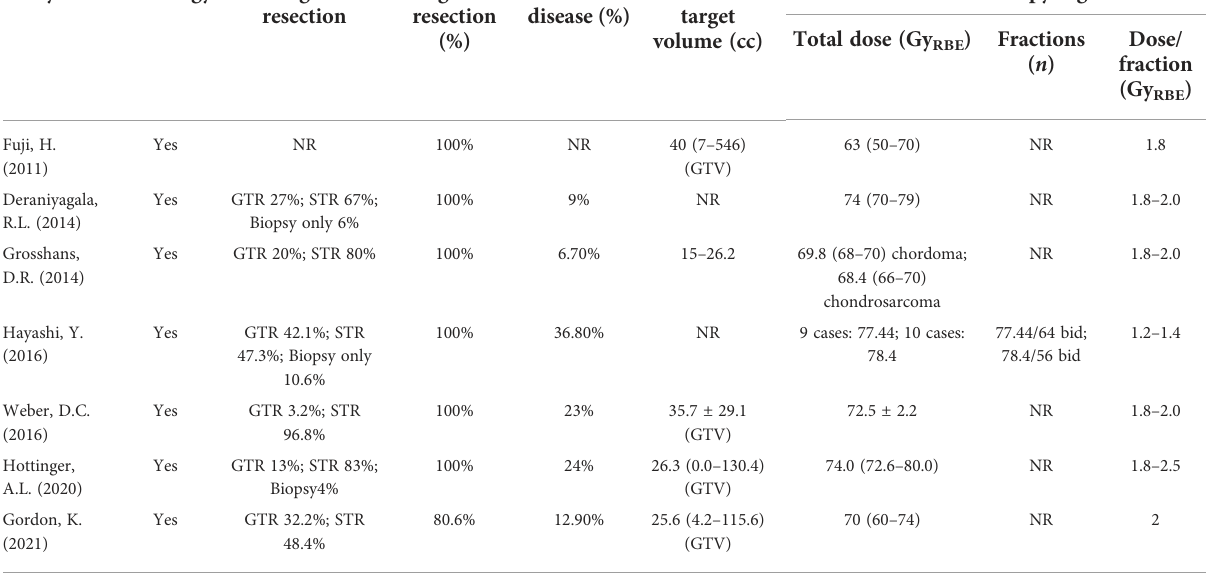
TABLE 2 Clinical features of all included